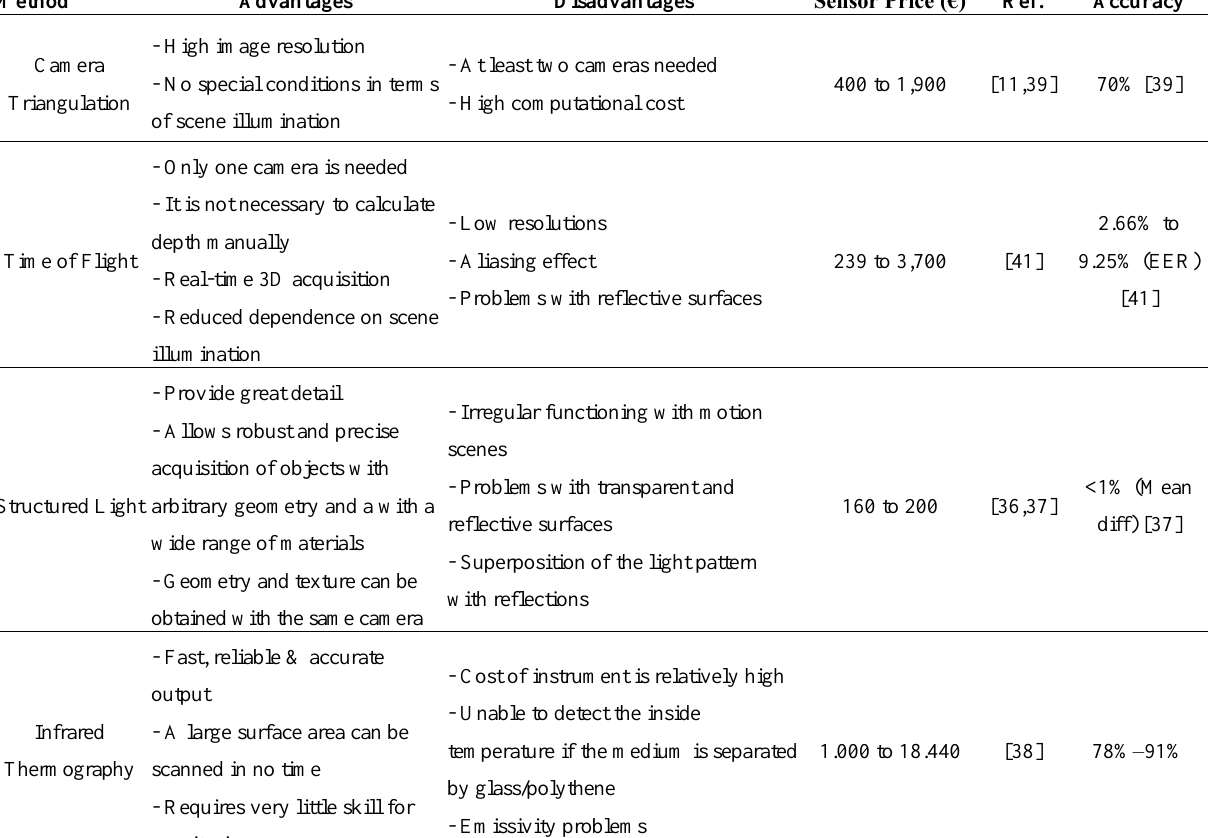
Table 2. Characteristics of different depth measurement